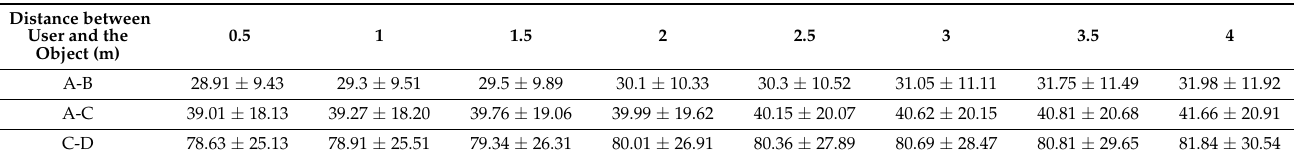
Table 2. Mean measurement error and its standard deviation for measurements taken at different distances from real and virtual